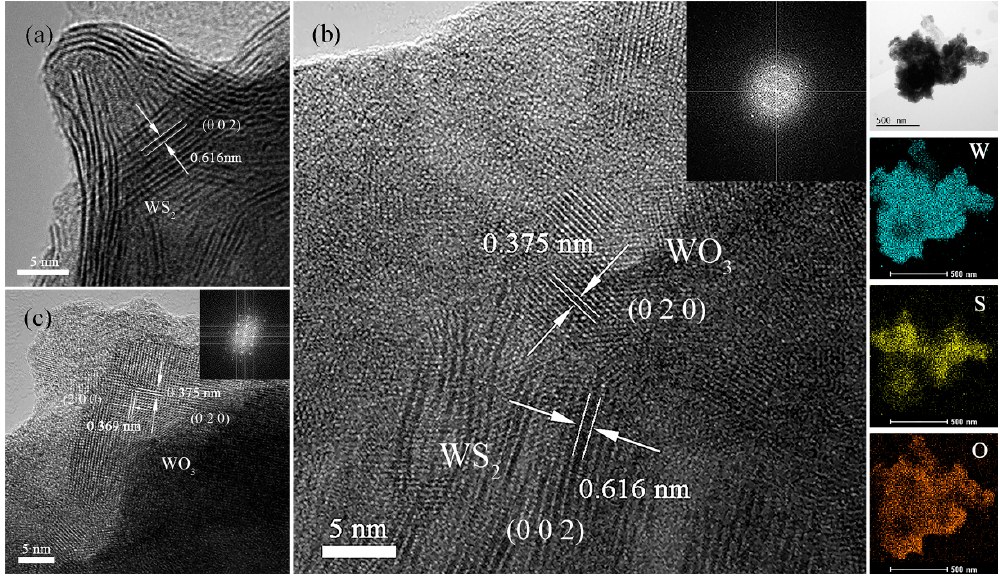
Figure 3. High ‐ resolution TEM (HRTEM) images of ( a ) WS 2 , ( b ) WSO ‐ 5, ( c ) WO 3 , and ( b inset) Figure 3. High-resolution TEM (HRTEM) images of ( a ) WS 2 , ( b ) WSO-5, ( c ) WO 3 , and ( b inset) elemental mapping of WSO ‐ 5. elemental mapping of